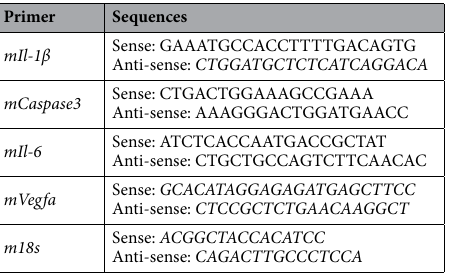
Table 1. The primer sequences for mRNA in